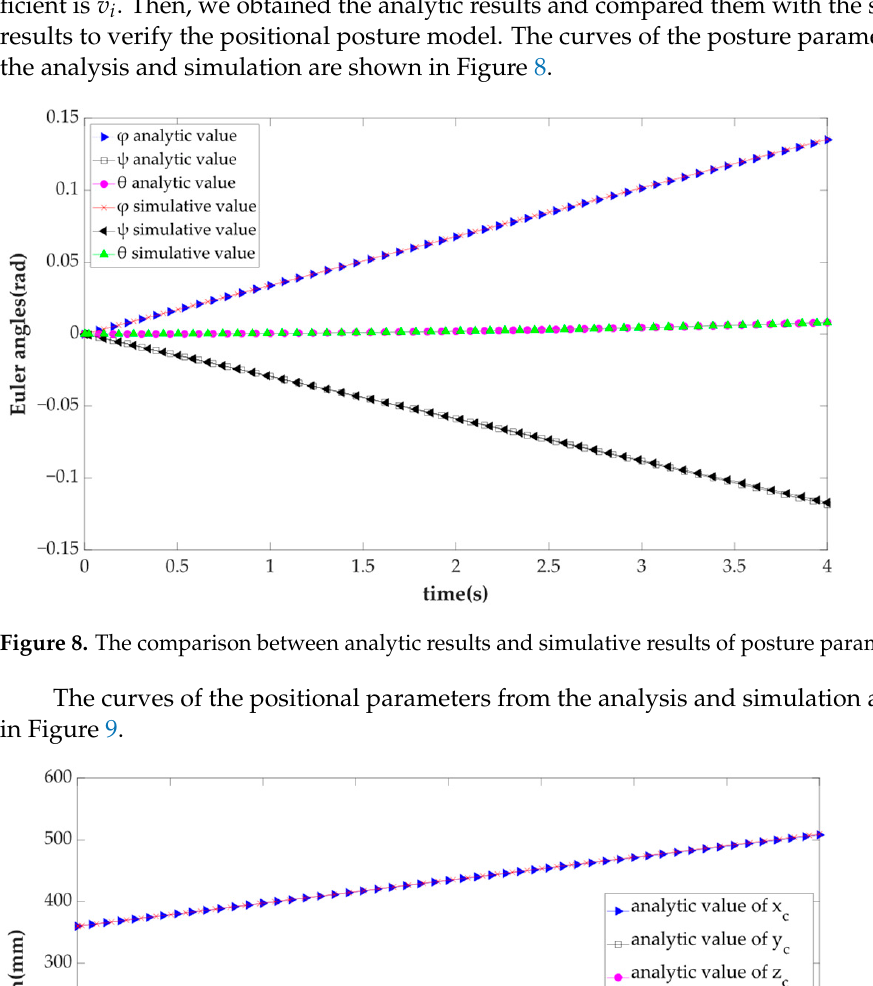
Table 2. The comparison of simulative and analytic values of positional posture parameters.